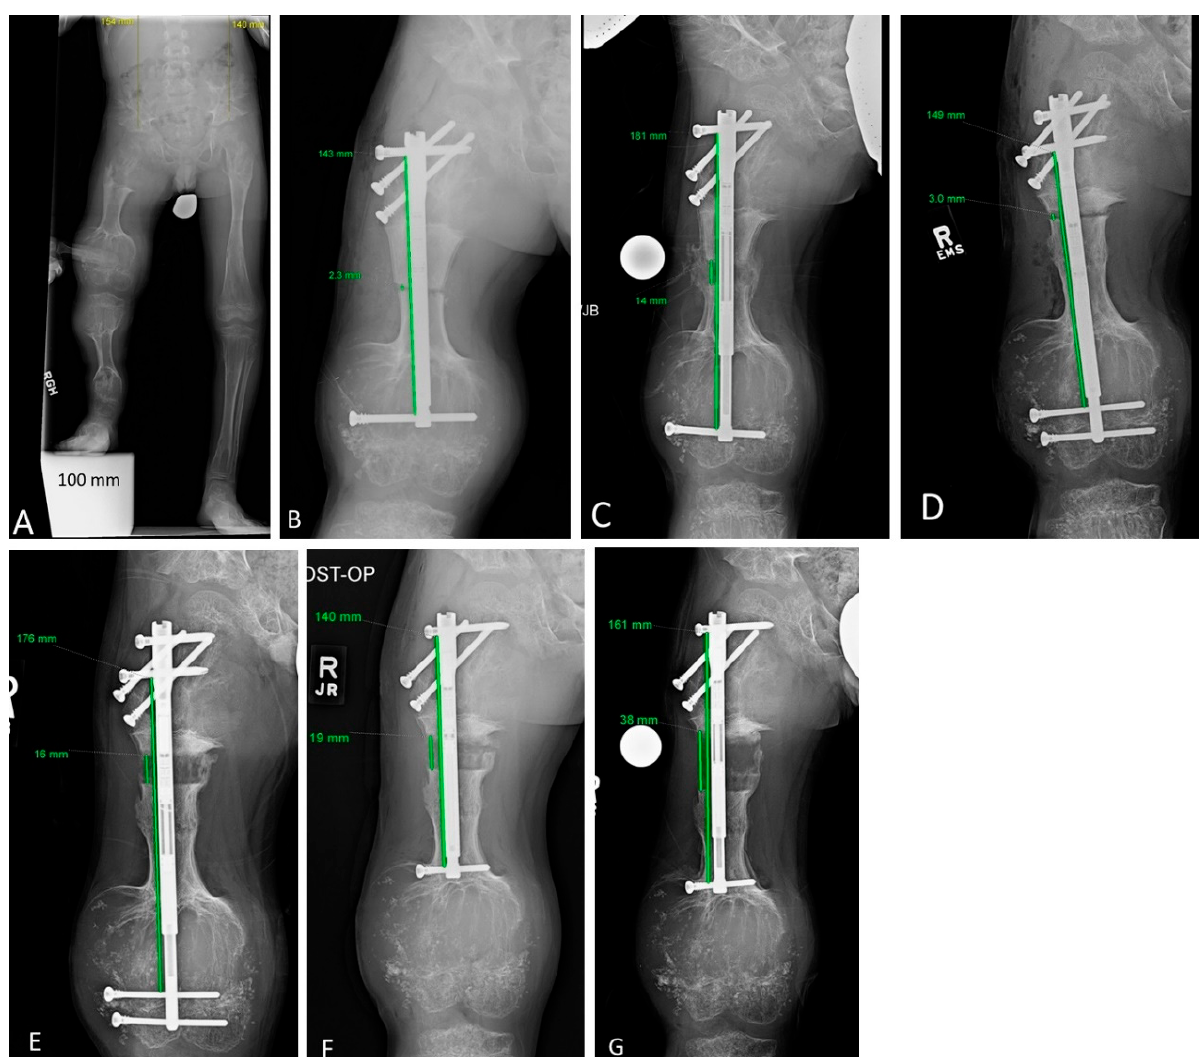
Figure 2. Limb lengthening episode complicated by mismatched hardware and osteotomy distraction. This figure portrays Patient 5’s lengthening experience. A 7-year 3-month-old male with enchondromatosis affecting all long bones of both legs, most severely the right femur and tibia. The initial diagnosis was Ollier’s disease. ( A ) His first lengthening was performed to address left greater than right leg discrepancy of 114 mm. ( B ) He was managed with right femur osteotomy and implantable lengthening nail (Precice). The angled femoral neck screws are anterior to the nail and were placed to prophylactically reinforce the femoral neck. The proximal and distal cross-locking screws are intralesional. ( C ) The nail eventually elongated approximately 40 mm, while the osteotomy gap elongated only approximately 12 mm, which along with the noticeable difference of the distal cross-lock screw position relative to the condyles, indicated the distal intralesional fixation provided insufficient purchase. The patient had never experienced any pain or other complications other than the mismatch between nail elongation and osteotomy distraction. ( D ) Given there was no need for emergent intervention, the patient was given a consolidation period of one year and lengthening was attempted again. A longer nail was inserted and cross-locking screws were placed on either side of the distal physis. ( E ) Premature consolidation and nail migration was redemonstrated; there was a nearly 2:1 nail:osteotomy elongation mismatch. ( F ) Fixation was changed to a shorter nail which, although allowing only one distal cross-locking screw, it was placed in extralesional bone and intra-operatively felt stronger during drilling and insertion. ( G ) The nail and osteotomy gap then lengthened proportionately; he eventually achieved 47 mm of distraction and was stopped due to proximal screw migration. While this patient remained under postoperative lengthening observation, his diagnosis evolved from Ollier’s disease to Maffucci’s syndrome, based on the development of